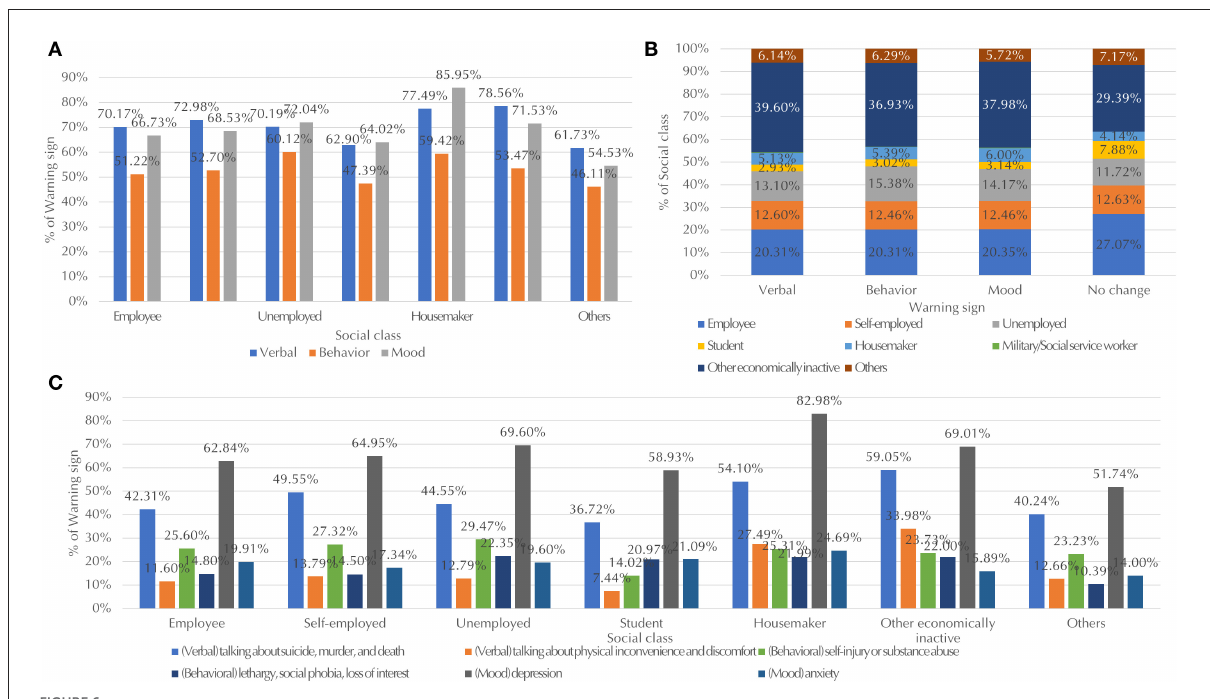
FIGURE6 (A) Distribution of warning signs across social classes (measured by employment status), (B) distribution of social classes across warning signs, and (C) distribution of subcategories of warning signs across social classes. For (A,C) , military or social service workers, which accounted for approximately 0.2% of the total suicide victims, were excluded. Additionally, for (C) , only subcategories of warning signs that differed across social classes are shown, and subcategories that accounted for < 10% of the total suicide victims were excluded. In (B) , data for military or social service workers, which accounted for < 1% of victims displaying each warning sign, are not shown due to limited